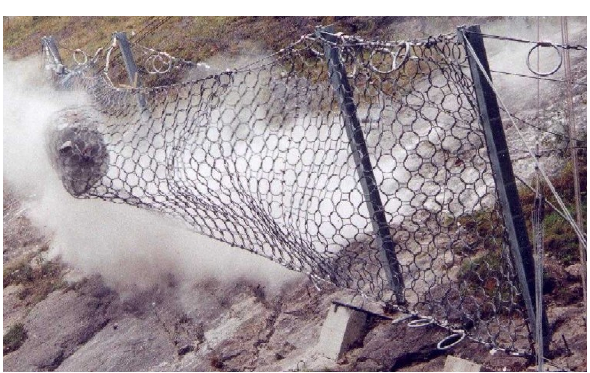
Figure 1. Example of flexible rockfall protection barrier in action (source: Fatzer).